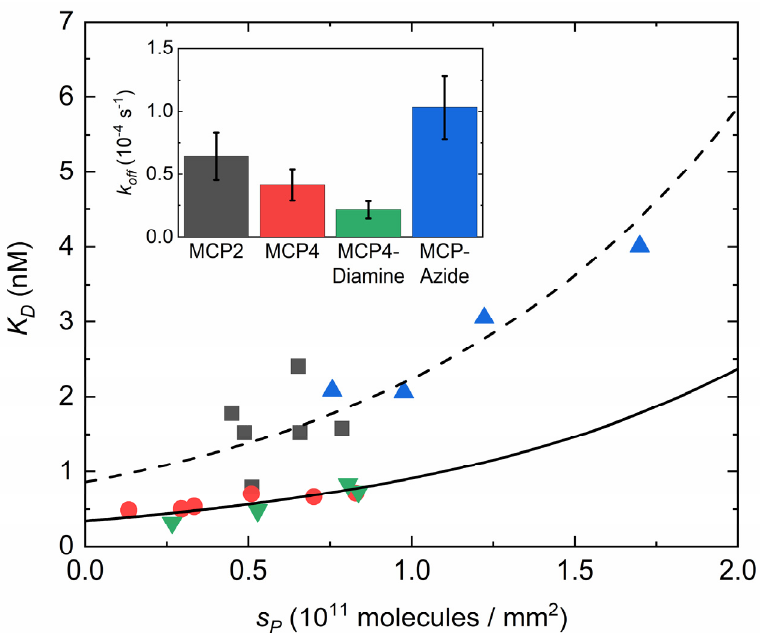
Figure 5. Equilibrium constant for dissociation K d The data points represent K d = k of f / k on for DNA hybridization on different copolymers. The black continuous and dashed curves are fit with Equation (6) to red–green and black–blue points, respectively. Inset: average value and standard deviation for the dissociation rate constant k of f . The colors of points and curves of the main panel correspond to the copolymers as indicated in the inset.